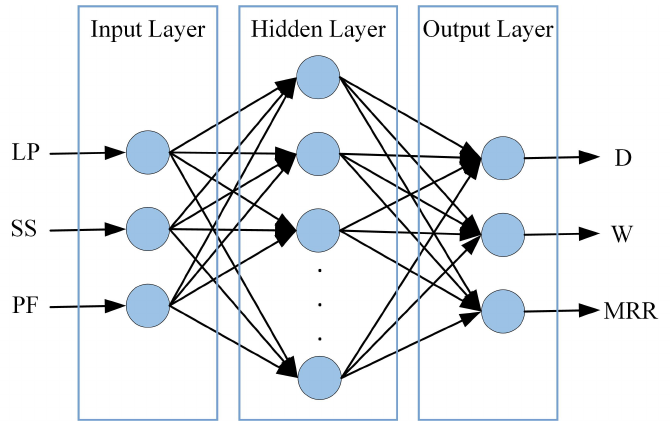
Figure 10. Effect of laser power and pulse frequency on the MRR.